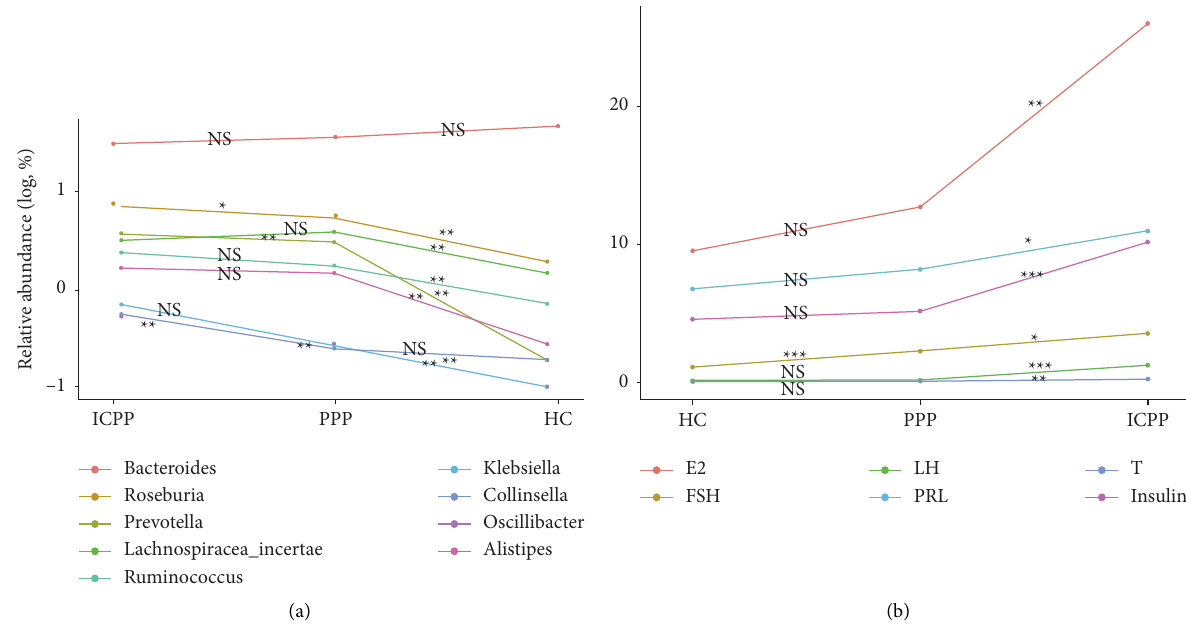
Figure 3: Te abundance trend of the diferential genera (a) and clinical phenotypes (b) in the HC, PPP, and ICPP groups. Te asterisks and NS indicated the P -values. ∗ , ∗∗ , ∗∗∗ , and NS (no signifcance) stand for the P -value smaller than 0.05, 0.01, 0.001, and P -value no less than 0.05,